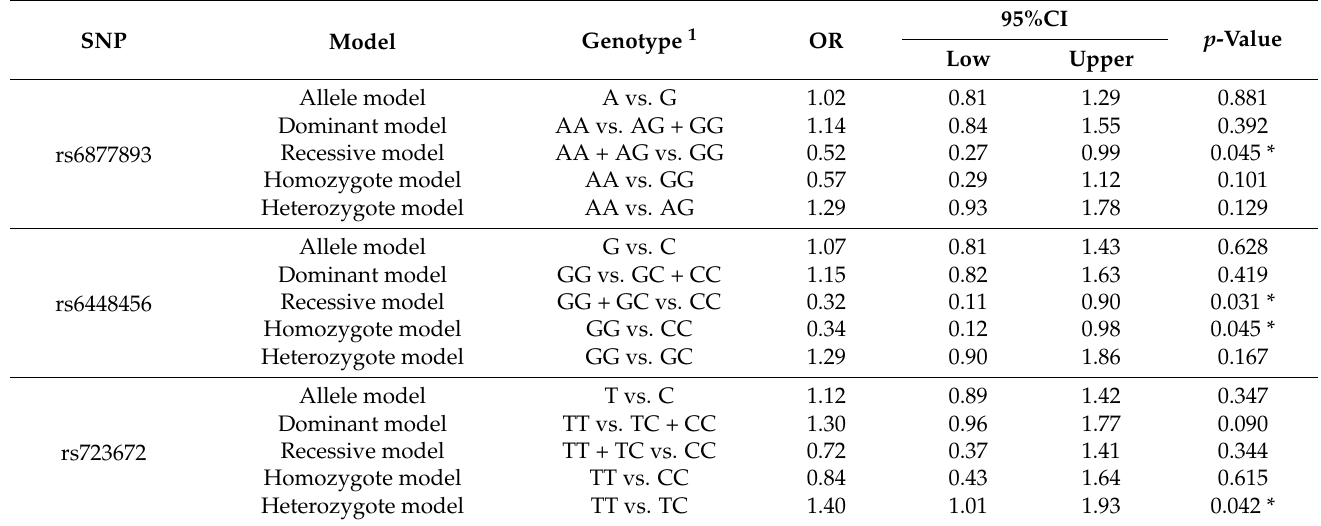
Table 2. The results of allele, dominant, recessive, homozygote and heterozygote regression models for a single